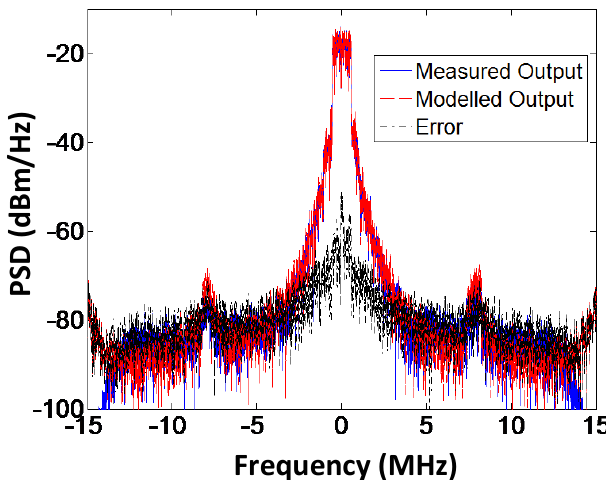
Figure 16. Spectral response of the modeled and measured output along with the error signal for the analog combining architecture. The proposed method is capable of reducing the modeling error even for analog combining.